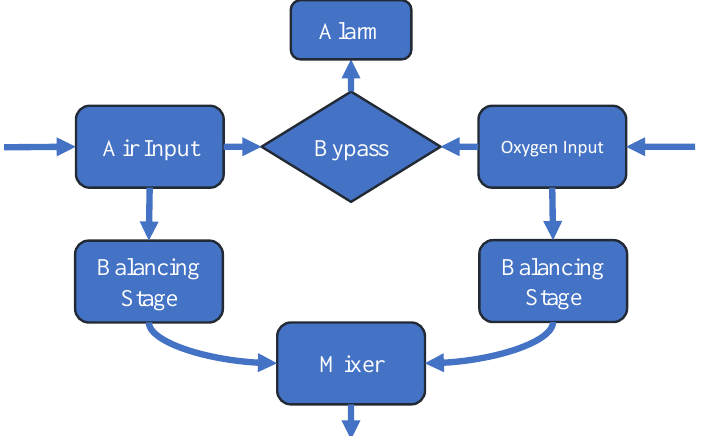
Figure 3. Simplified block diagram of the operation of an air–oxygen